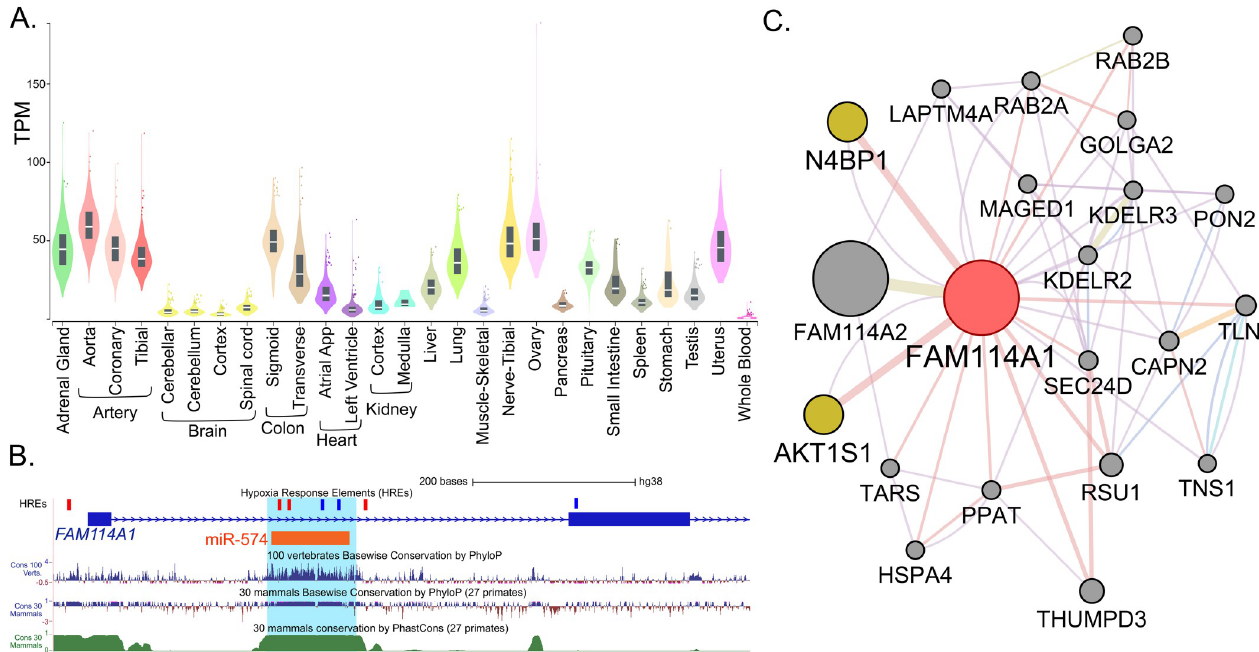
Fig 3. Distinctive properties of FAM114A1 and its role in hypoxia. (a) FAM114A1 is expressed in most of the tissues but its expression is low in the nervous system. (b) Position of hypoxia-response elements (HREs) consenses in FAM114A1 and intronic miRNA, miR-574 in intron-1. The region constituting miR- 574 is evolutionarily conserved. (c) Network analysis reveals physical interaction of FAM114A1 with AKT1S1 (AKT1 substrate 1) and N4BP1 (NEDD4 binding protein 1).